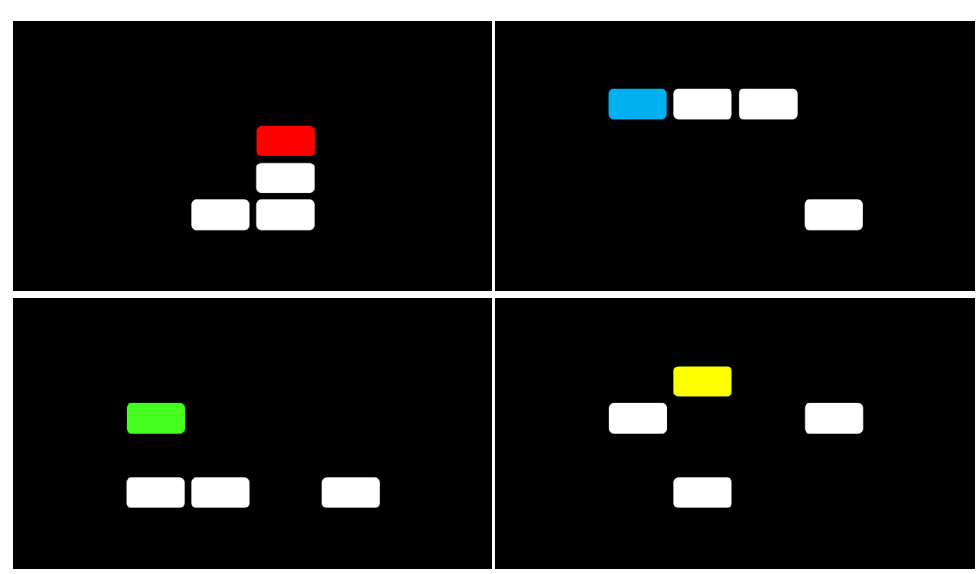
Figure 2. Pattern appearance in the MPMT; representative examples taken from Block 1 ( upper left ), Block 2 ( upper right ), Block 3 ( bottom left ), Block 4 ( bottom right ).